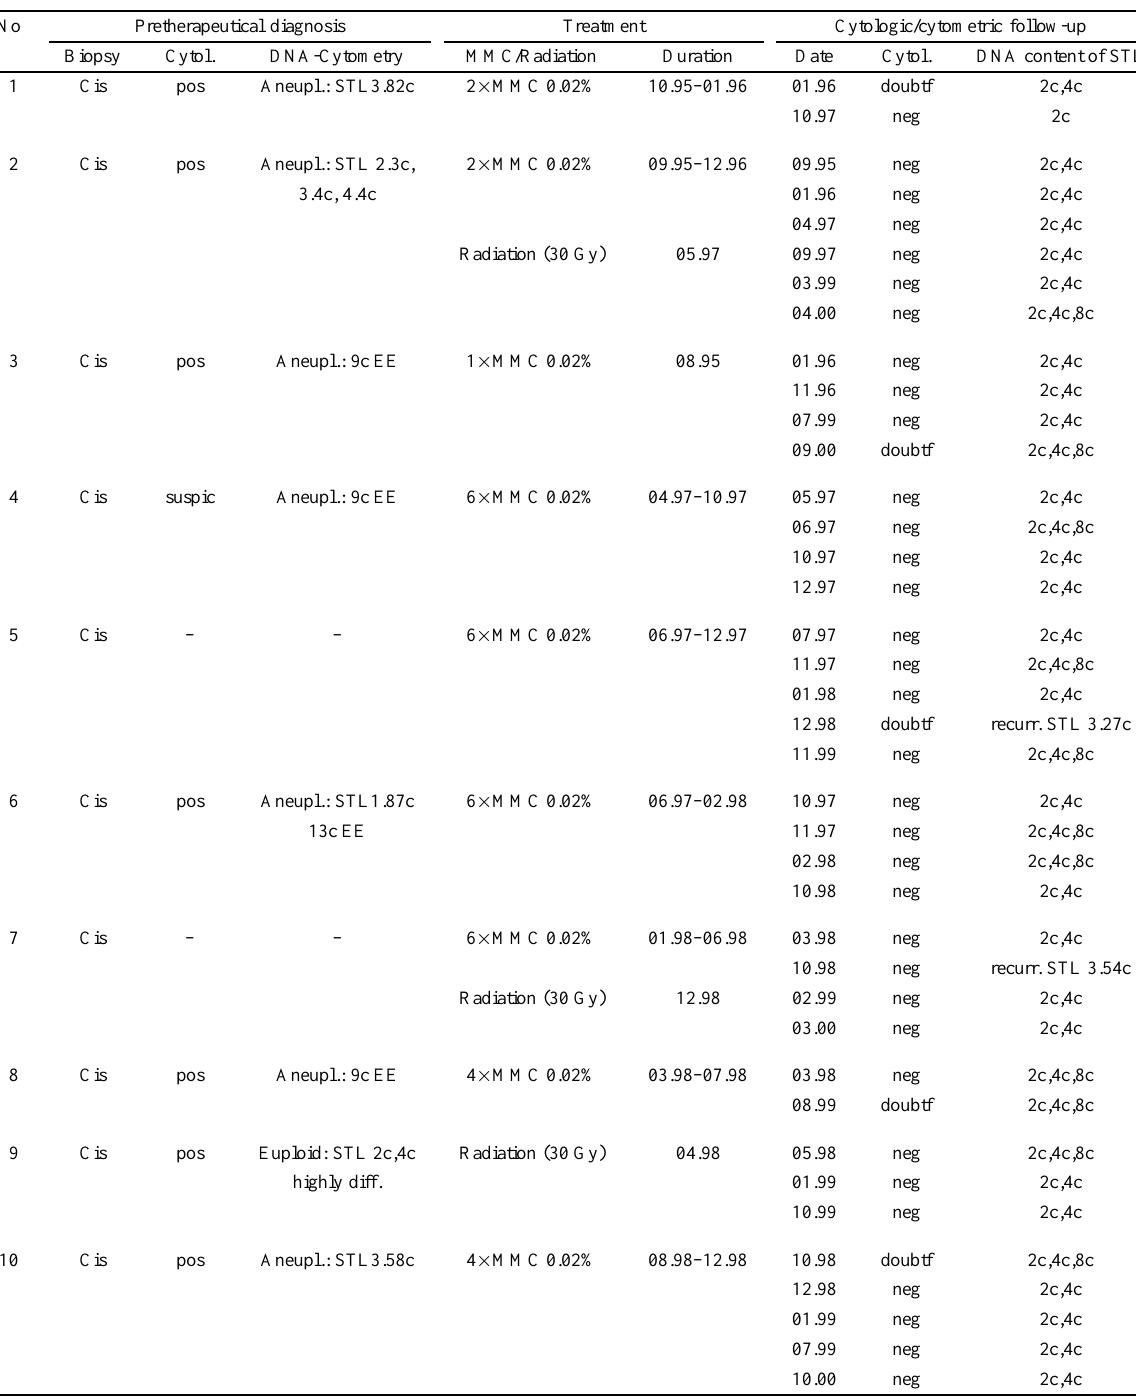
Summary of clinical data, diagnoses, treatment and follow ups of patients with carcinoma in situ of the